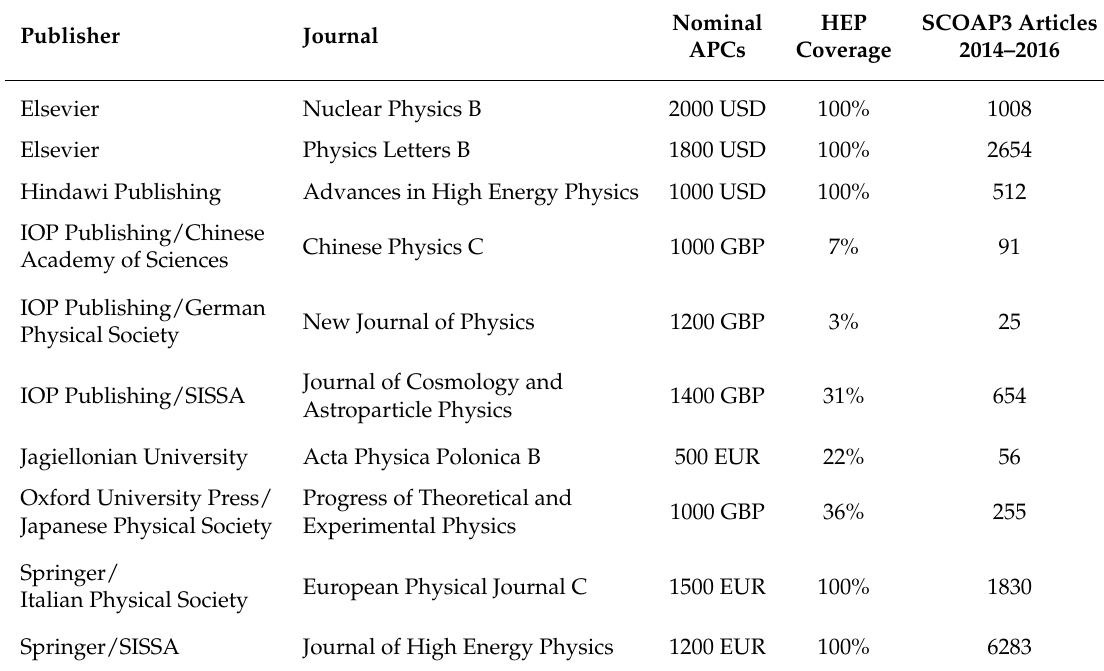
Table 1. List of publishers and journals participating in the first 3-year cycle of SCOAP3 (2014–2016), alongside the nominal charge per article (effective charges differ, and are calculated as described in the text), the fraction of the journal covered by SCOAP3 and the number of articles covered over the first three years of the